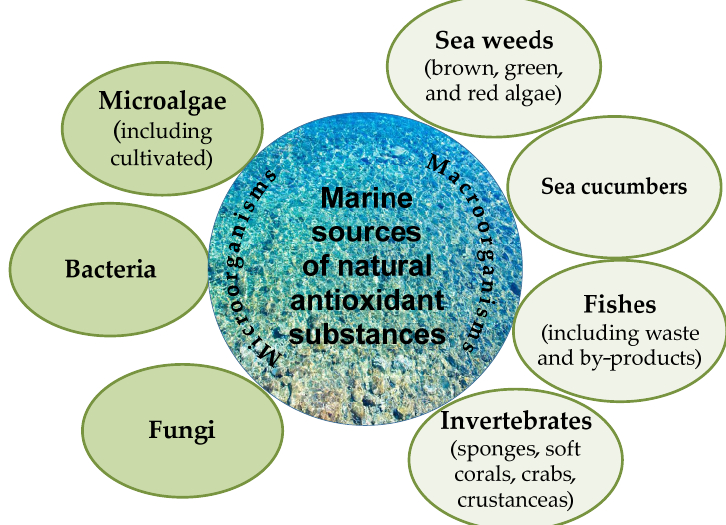
Figure 2. Main marine sources of substances with antioxidant activity.